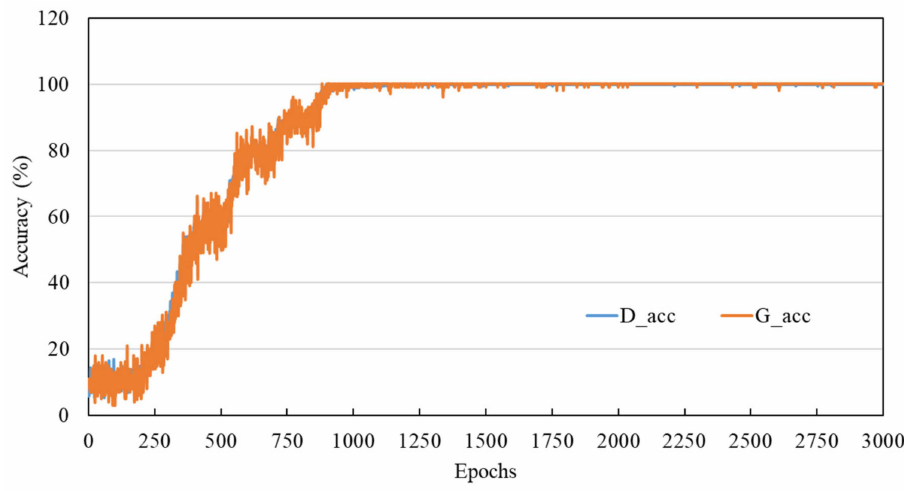
Figure 7. The discrimination loss and generation accuracy curve of the ACGAN-SN model.